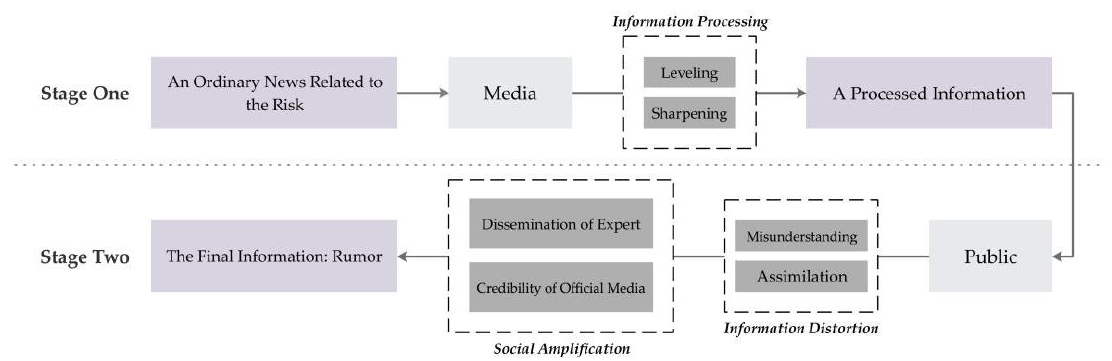
Figure 1. The forming mechanism of the Shuanghuanglian (SHL) rumor.